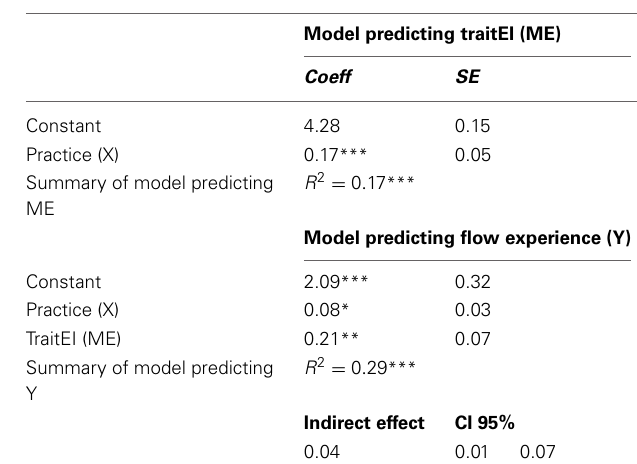
Table 5 | Indirect effect of daily amount of practice on flow experience through trait emotional intelligence ( N =